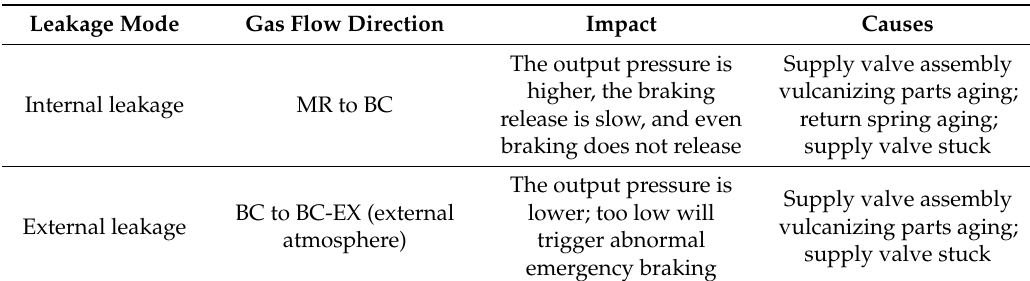
Table 1. Relay valve leakage